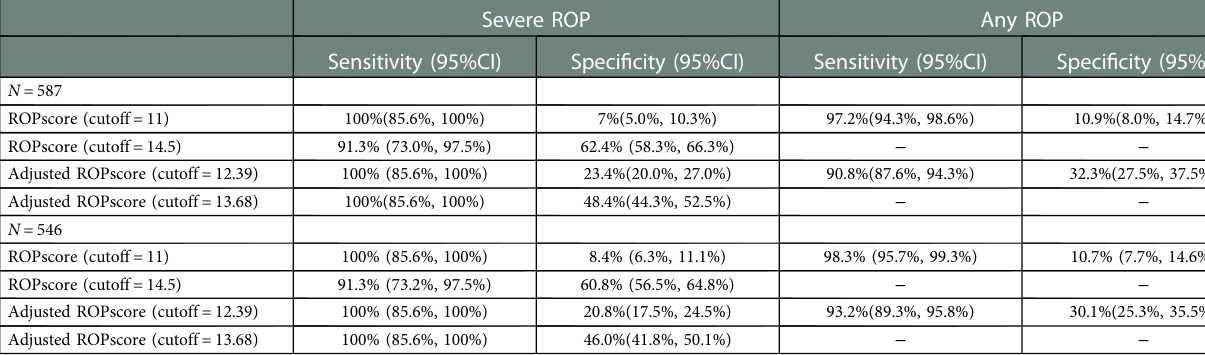
TABLE 3 Prediction of severe ROP and any ROP using ROPscore and adjusted ROPscore.